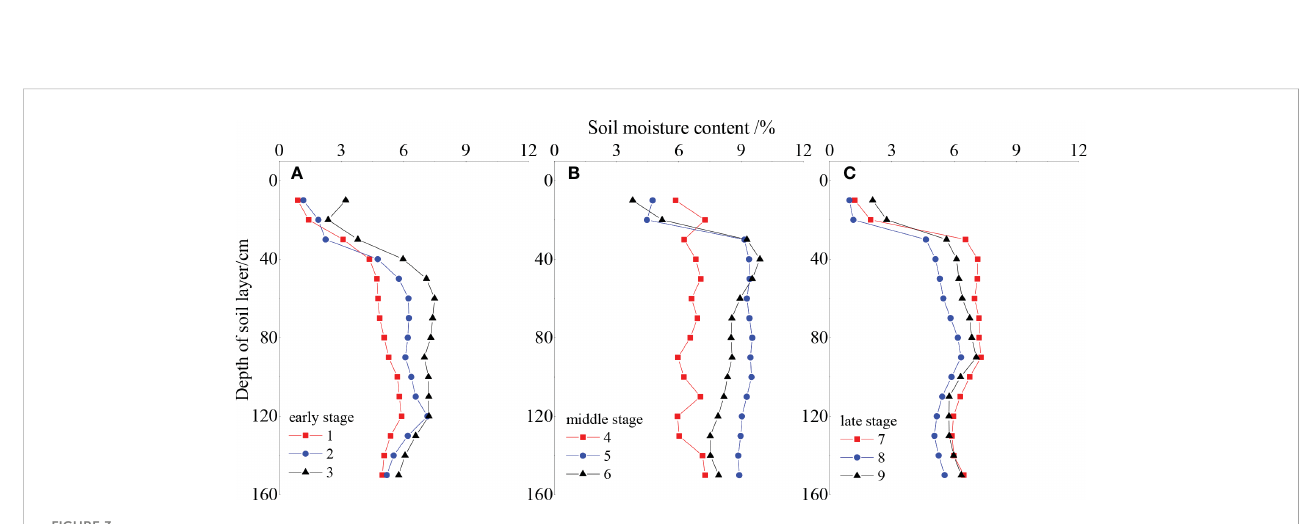
FIGURE 3 Dynamic of soil water content in different fencing periods (A) early, (B) middle and (C)